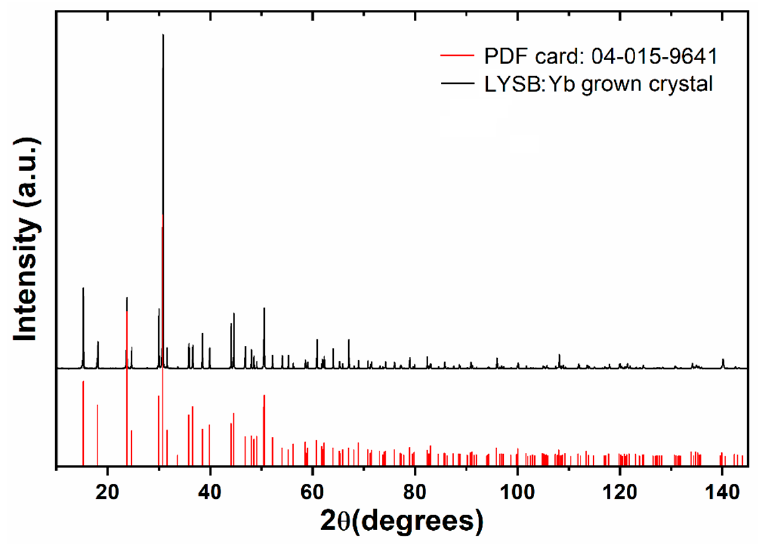
Figure 18. XRPD spectrum of LYSB:Yb crystal (black line) together with PDF card 04-015-9641 (red sticks) of LGSB crystal. Reprinted with permission from ref. [44], copyright 2020, Elsevier.